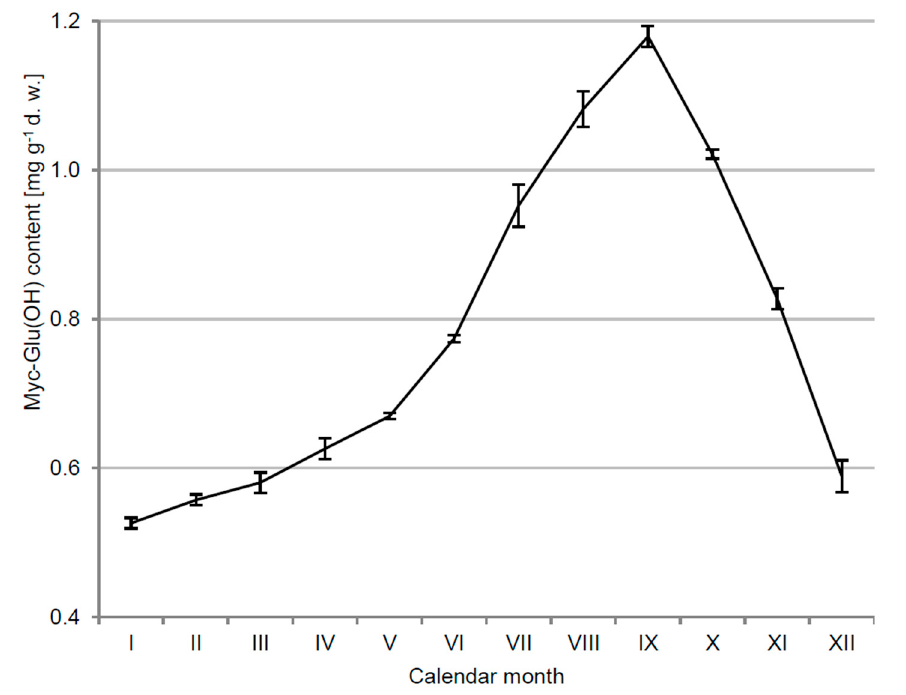
Figure 2. The concentration of Myc-Glu(OH) in C. arbuscula thalli throughout 2014 calendar year; n = 5 ± S.D., d.w.—dry weight.